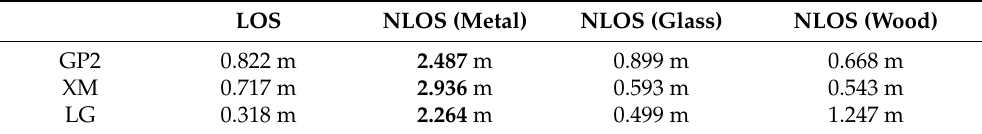
Table 4. Comparison of the RMSE in RVPV environment.